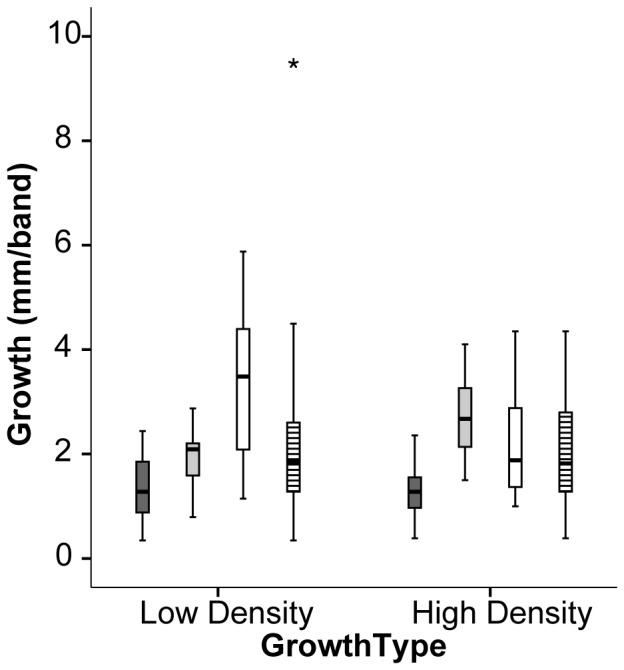
Coral extension length (mm band−1) plotted to show the median (bold mid-line), the first and third quartiles (box), and 1.5 times each quartile (black lines) for low-density (dark) and high-density (light) banding.The bandings are described for Lamma Island (dark shading), Pak Lap Tsai (light shading), Crescent Island (no shading), and all sites (striped). Outlier (star) for all three sites was defined as >3 times each quartile.